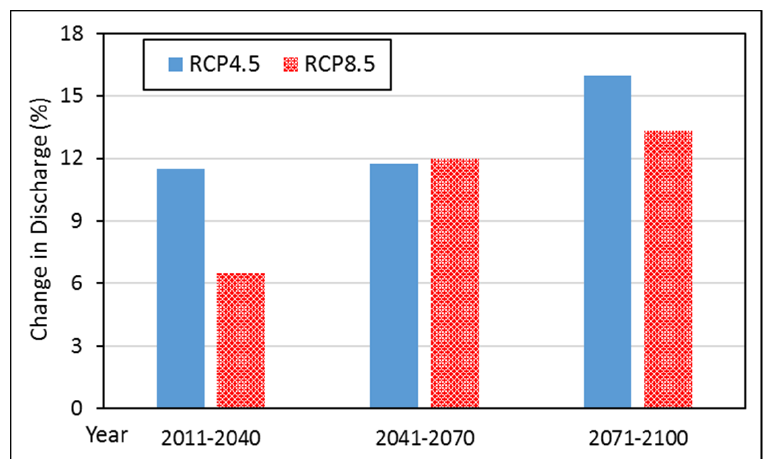
Figure 4. Percent changes in annual runoff.